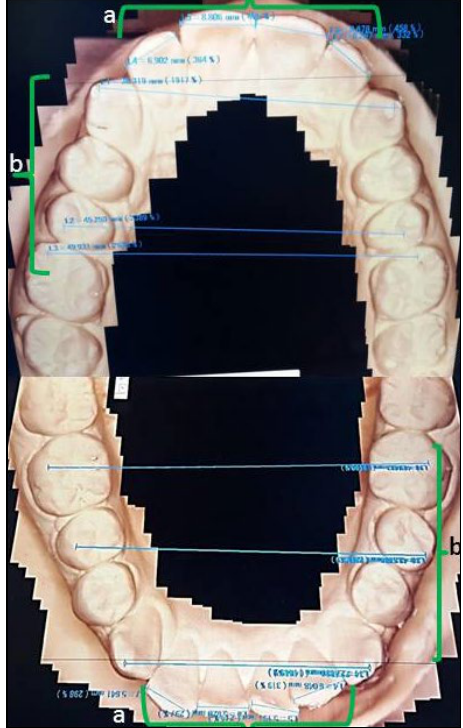
Figure 2. Measurement of maxillary and mandibular arches: (a) incisor mesiodistal crown diameter, (b) arch